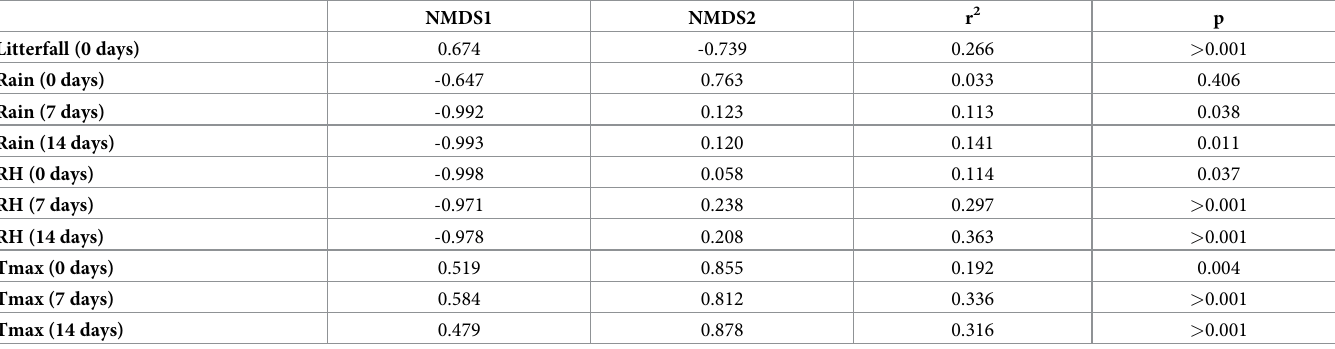
Table 2. Fitted environmental variables into the NMDS axes.